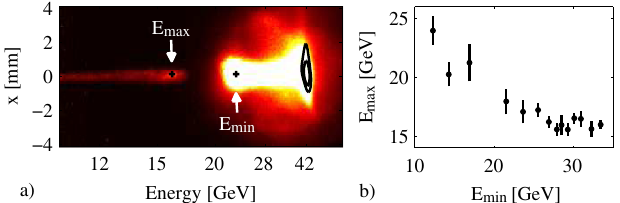
Energy [GeV] FIG. 4. (Color) (a) A saturated image from the energy spec- trometer, where the black contour lines show the drive bunch spot size in the absence of plasma acceleration. Trapped elec- trons appear as a streak with an rms x size that is much smaller than that of the drive bunch. The black plus signs denote the maximum energy of the electron streak, E max , and the minimum energy of the drive bunch, E min , after accounting for the natural spot size of the electron bunches [26]. (b) The quantity E max versus E min , where the difference between the streak and drive bunch x rms size allows for a measurement of E max , even when it extends above E min .